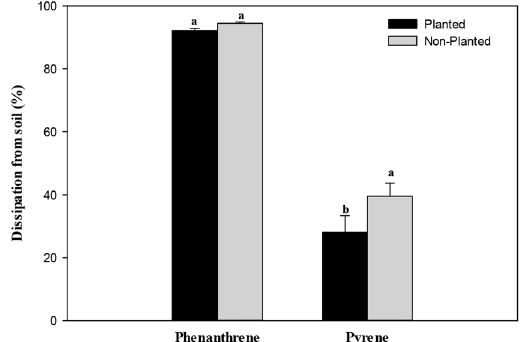
Figure 5. The percentage of polycyclic aromatic hydrocarbons (PAHs) dissipated (%) from soils influenced by PAH treatment after 60 days of Acorus calamus growth (there was no significant interaction between Cd treatments and soil with or without plants). Bars (mean ± SE, n = 18) with different letters (a,b) are significantly different based on the least significant difference test (p <